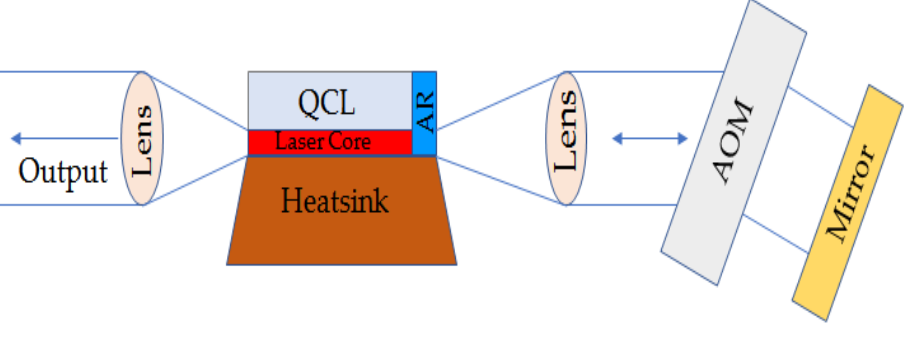
Figure 8. Structure of an AOM-controlled ECQCL.